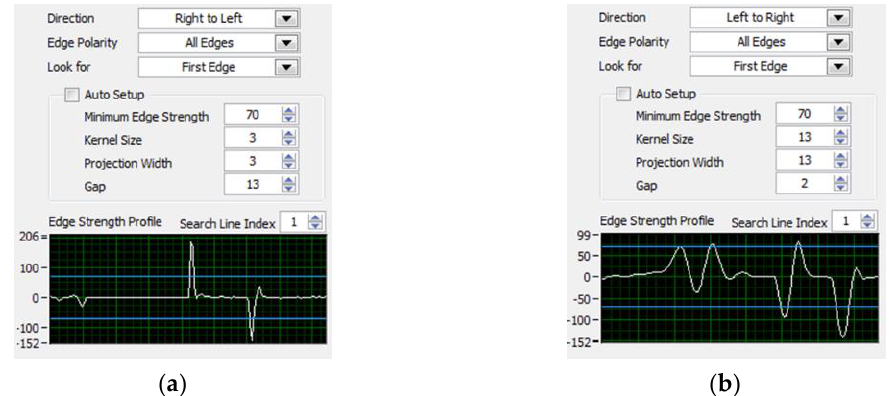
Figure 3. Edge detection parameter settings: ( a ) from right to left and ( b ) from left to right.